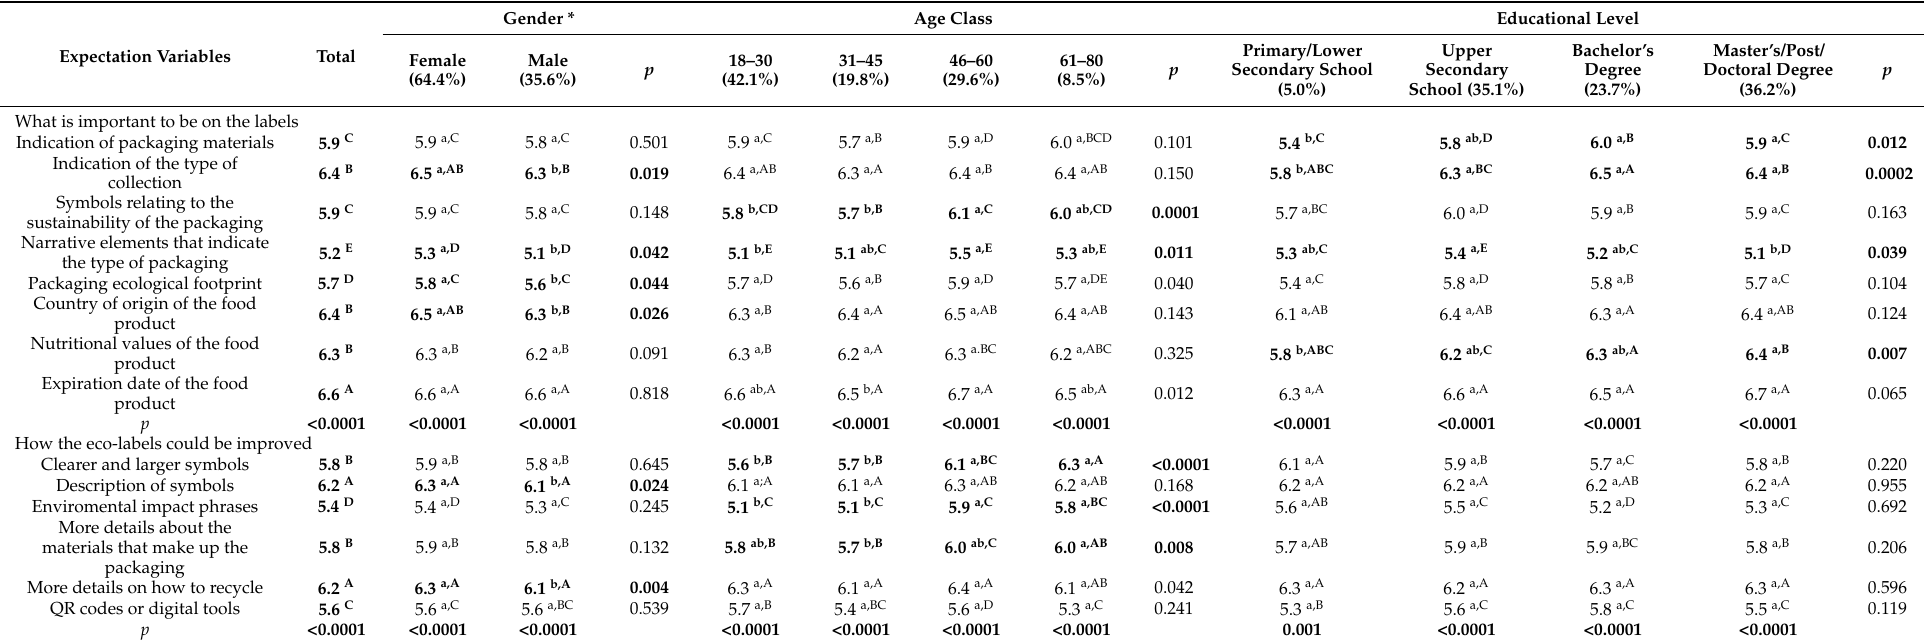
Table 3. Effect of socio-demographic characteristics on consumers’ expectations ( n =